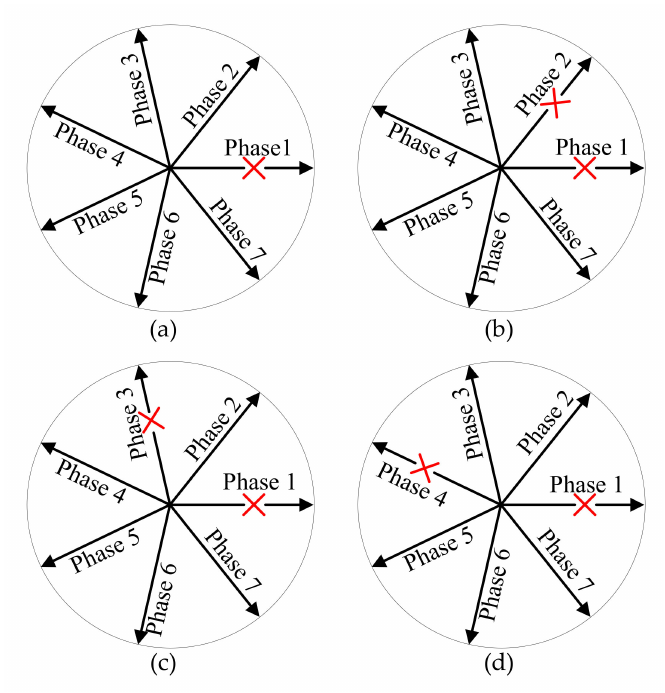
Figure 1. Spatial position of fault phases. ( a ) Fault 1: 1st phase fault; ( b ) Fault 2: 1st and 2nd phase fault; ( c ) Fault 3: 1st and 3rd phase fault; ( d ) Fault 4: 1st and 4th phase